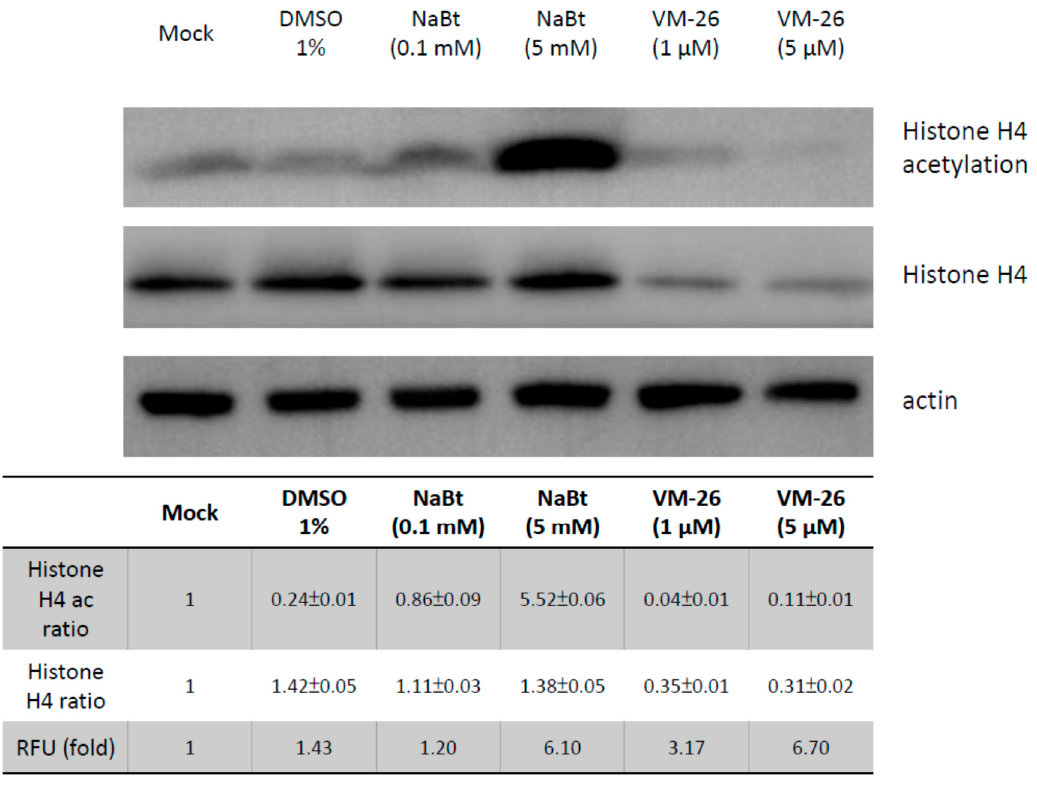
Figure 4. Cont. Figure 4.